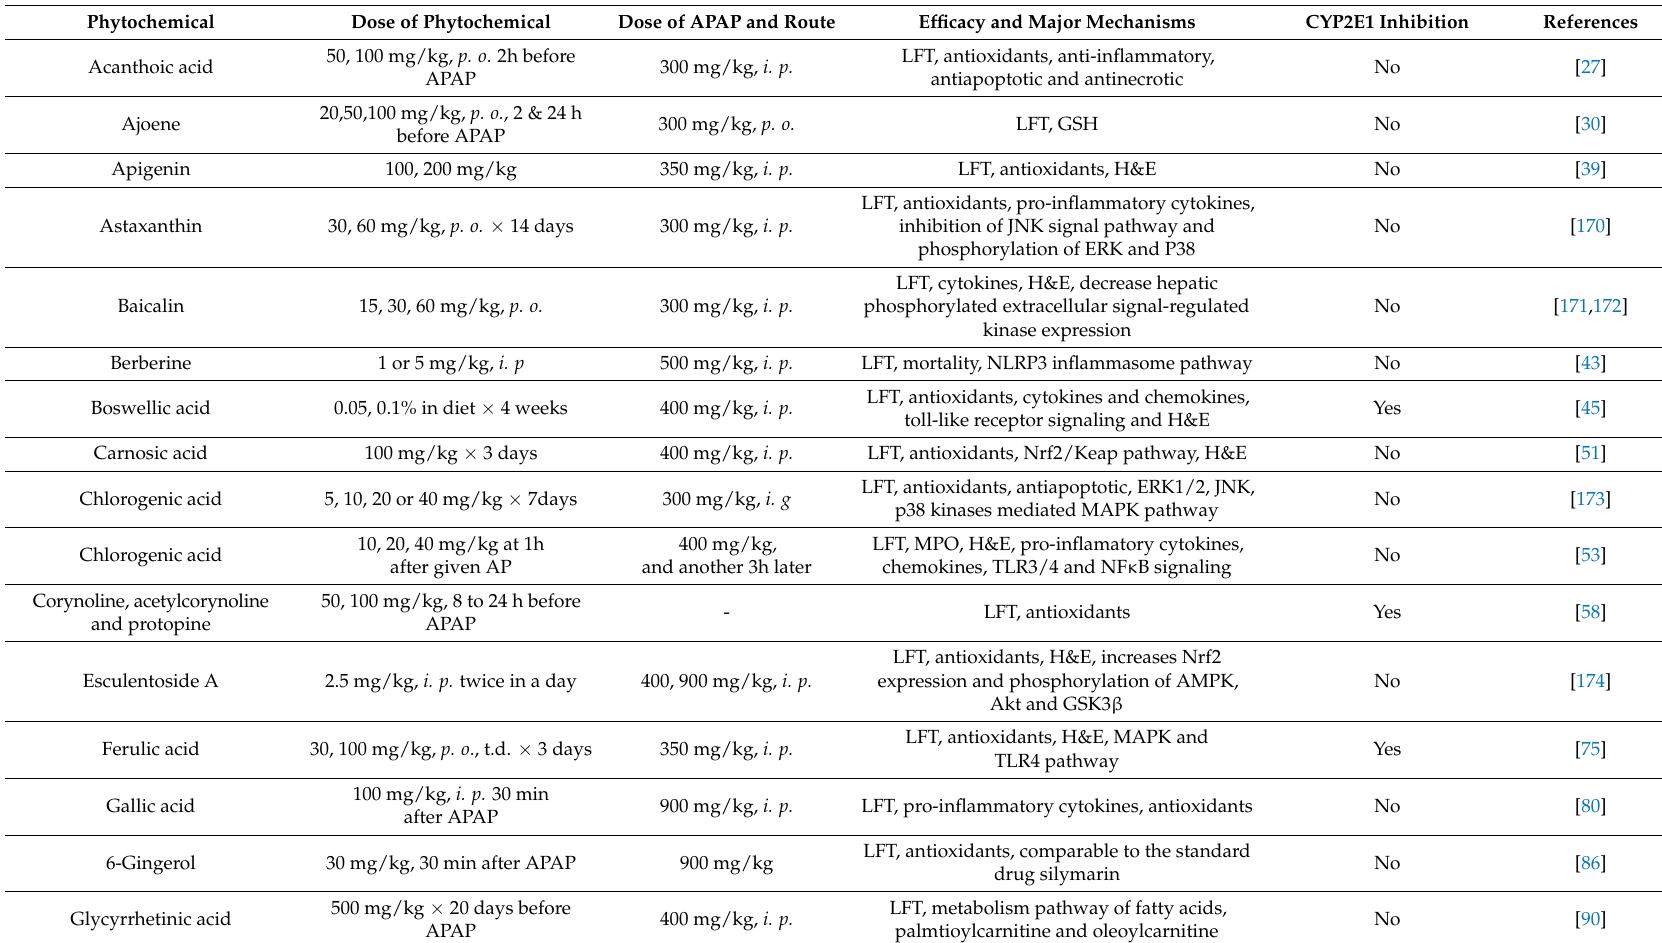
Table 1. Phytochemicals showed hepatoprotective effect in the mice model of acetaminophen-induced liver